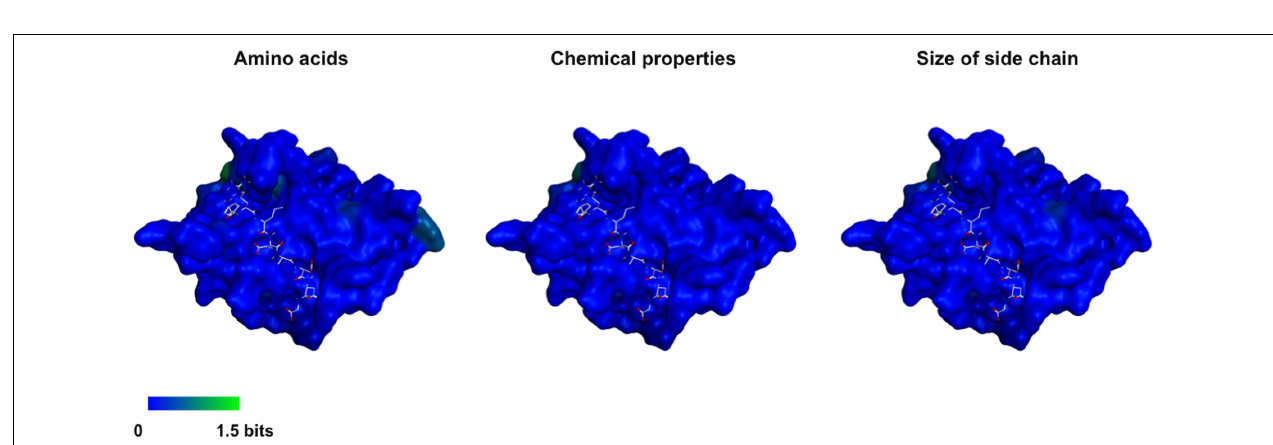
FIGURE 7 | Three-dimensional map of the amino acid variations among FCV proteases. Shannon entropy scores based on amino acids (Left) , chemical properties of amino acids (Middle) , and size of side chains (Right) . Amino acid sequences of the protease domain (154 amino acid residues in length) (Sosnovtseva et al., 1999; Oka et al., 2007) of FCV strains for which complete genome sequences were available as of 2013 June were obtained from GenBank ( n = 15, accession numbers: D31836, AF479590, U13992, M86379, AF109465, L40021, AY560118, AY560116, AY560117, AY560113, AY560114, AY560115, DQ424892, GU214989, and KC835209). Shannon entropy scores representing variations at individual amino acid positions of protein were calculated with a multiple sequence alignment as described previously for other viral proteins (Motomura et al., 2008; Naganawa et al., 2008; Oka et al., 2009). The entropy scores were expressed on the protease-octapeptide structure at 30 ns of MD simulation in Figure 6 . The substrate octapeptide (FCV F4-6) is shown using a gray stick model. An entropy score of zero indicates absolute conservation, whereas that of 4.4 indicates complete randomness.